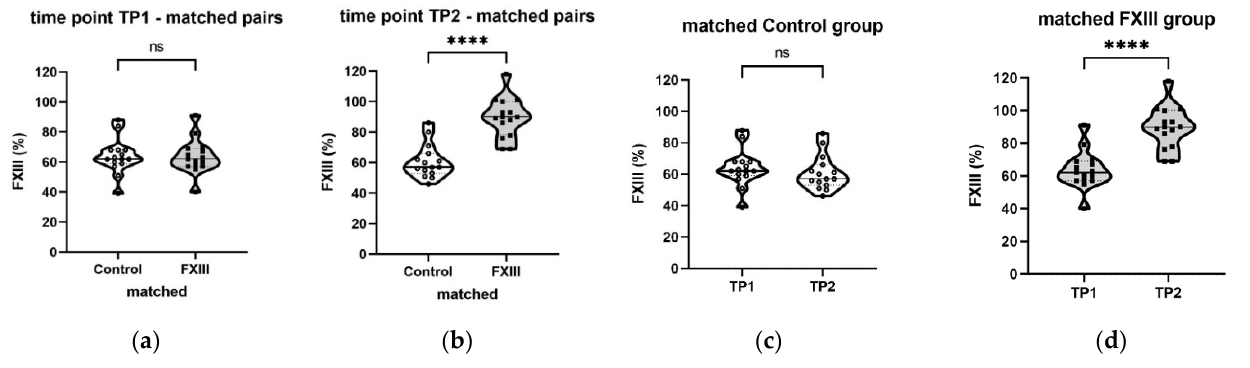
Figure 5. Differences in FXIII levels in the matched control ( n = 15) and matched FXIII ( n = 15) groups. ( a ) Between matched groups at TP1; ( b ) between matched groups at TP2; ( c ) within matched control group between TP1 and TP2; ( d ) within matched FXIII group between TP1 and TP2; TP, time point; level of significance indicates **** p < 0.0001; ns, not significant.